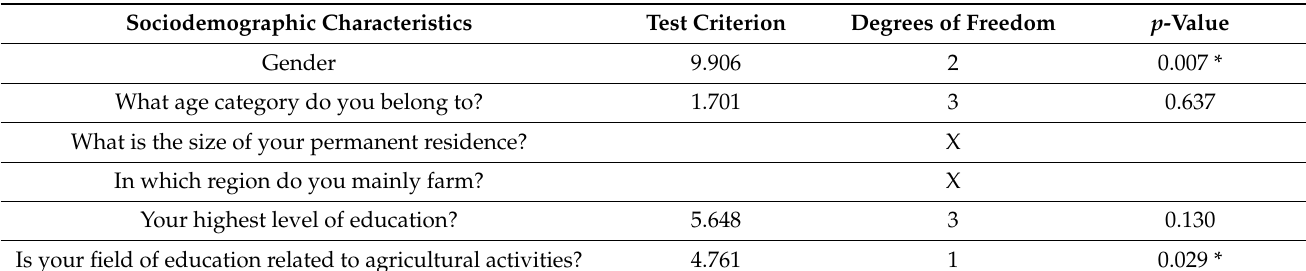
Table 2. χ 2 test for independence in contingency table.